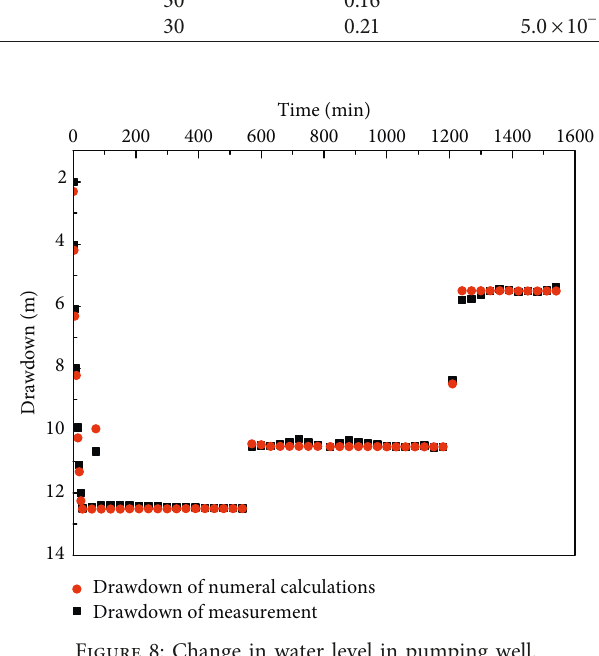
Figure 8: Change in water level in pumping well.